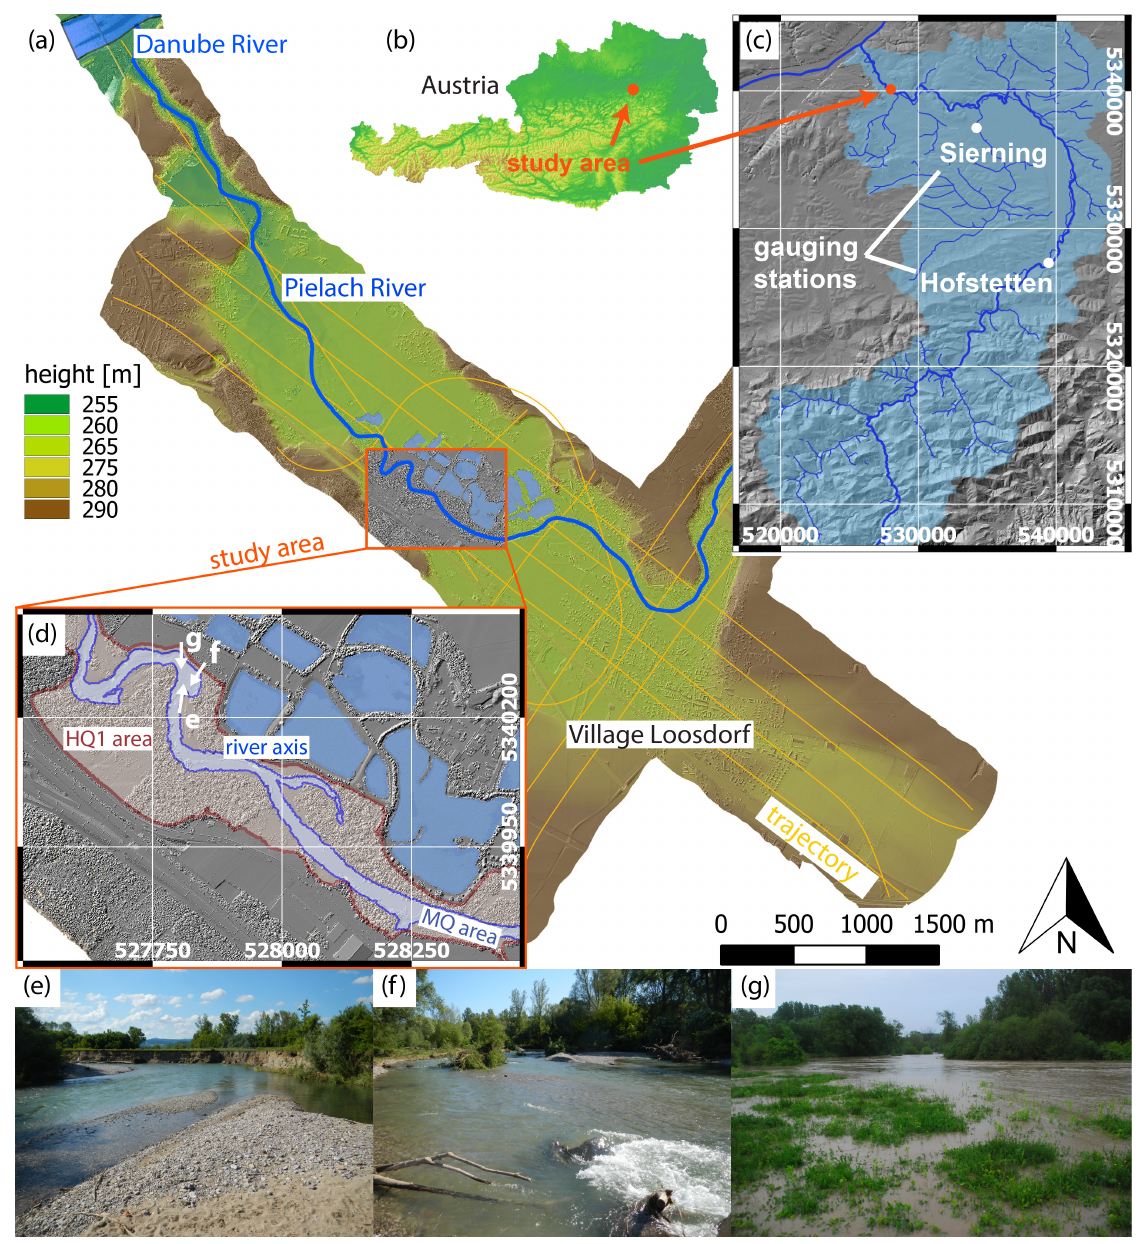
Figure 1. Neubacher Au, Pielach River, Lower Austria; ( a ) Flight block Loosdorf, shaded relief of digital surface model superimposed with color-coded elevation map and additional vector data (flight trajectory, river axis, freshwater ponds); ( b ) Overview map of Austria with marked location of study area; ( c ) Pielach River catchment and location of gauging stations; ( d ) Study area Neubacher Au, mean flow and annual flood area highlighted; ( e – g ) Terrestrial photos; ( e ) meander bend; gravel bank and bar, steep bank, backwater; ( f ) main channel with gravel bar, deadwood, and alluvial forest; ( g ) meander bend from top of the steep bank during flood event on 16 May